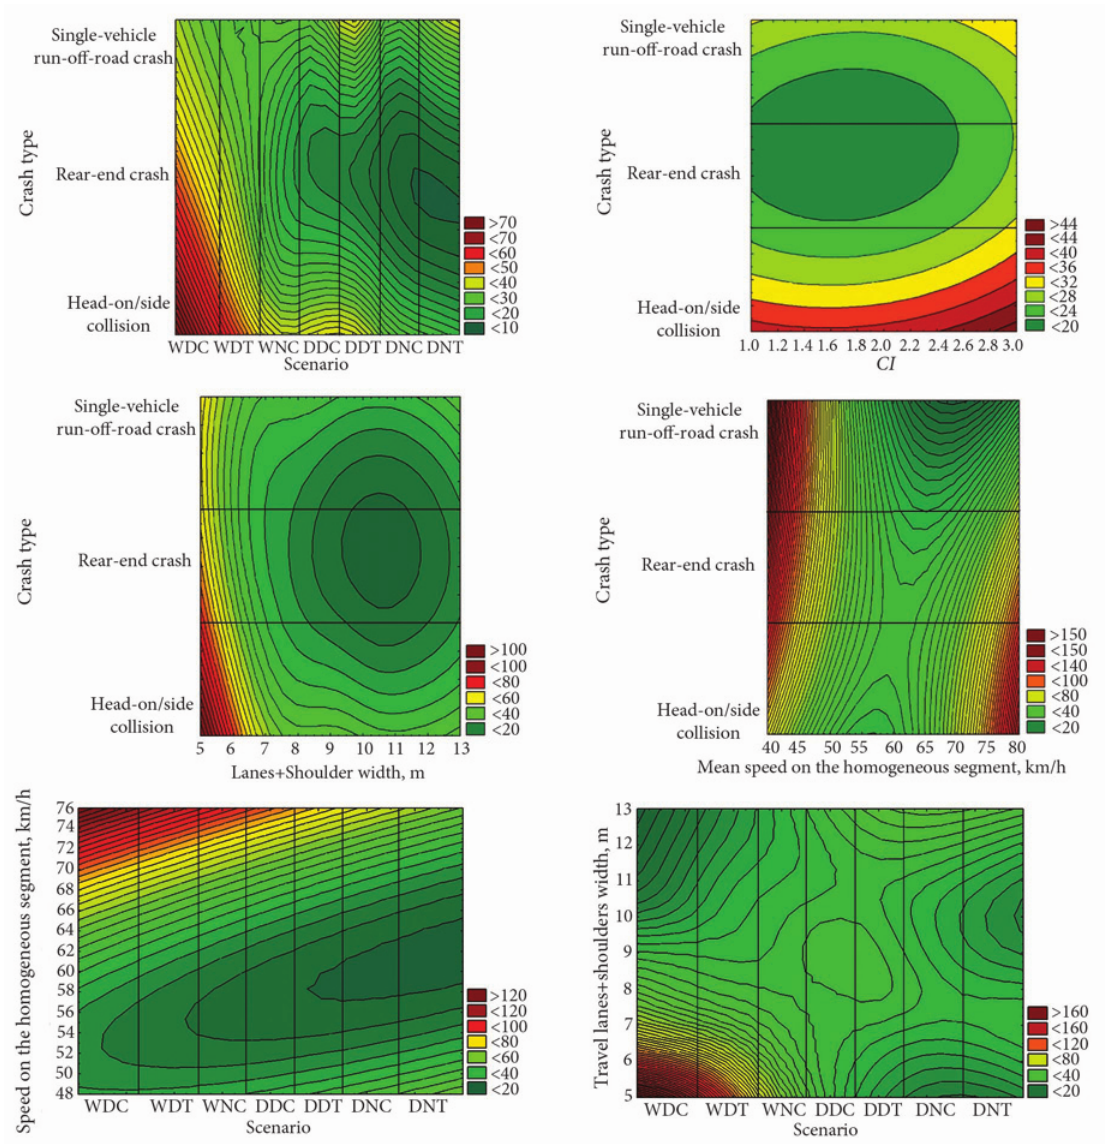
Fig. 1. Crash hazard